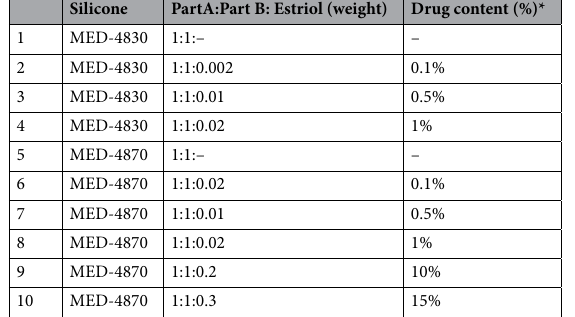
Table 2. Composition and estradiol content of silicone rings. *Drug content is presented as Mass of drug Mass of silicone % .